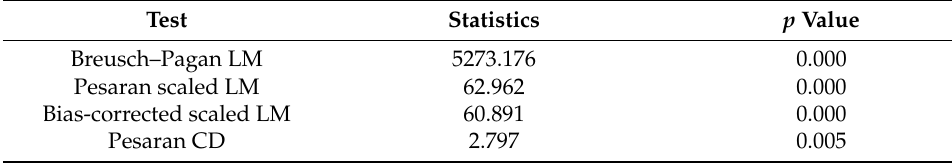
Table 4. Test for cross-sectional dependence.